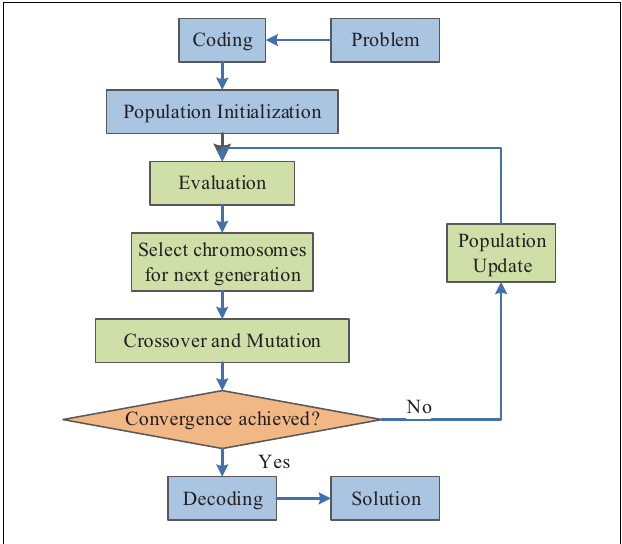
FIGURE 6 | Flowchart of SGA.